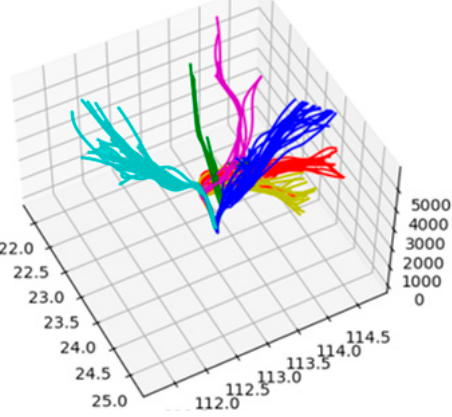
Figure 14. Final clustering result.